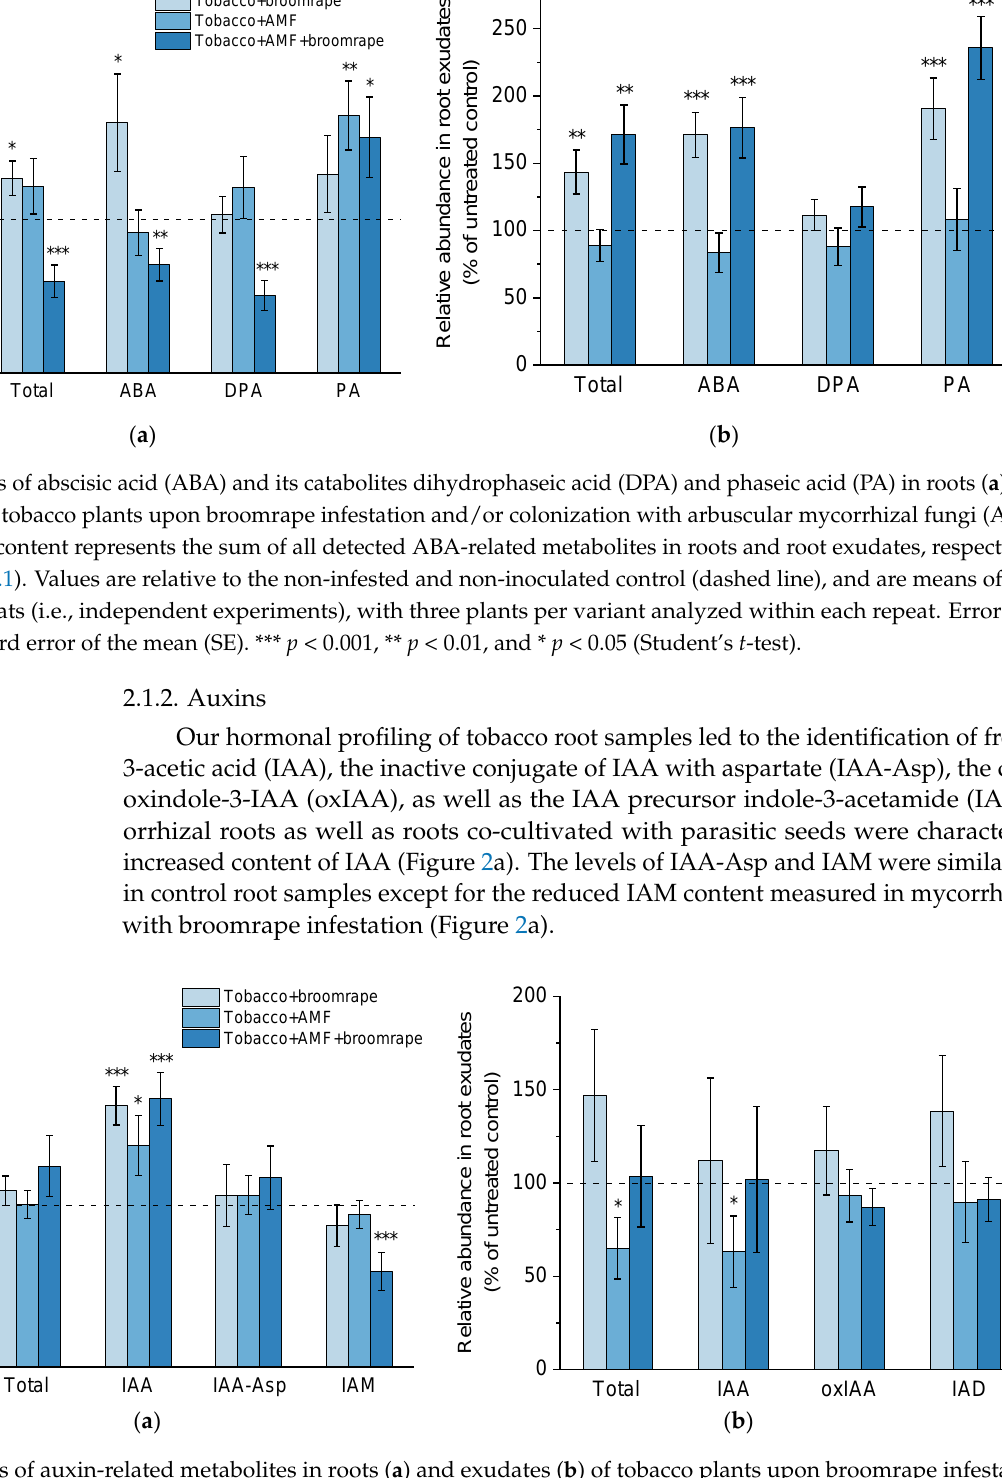
Figure 2. Levels of auxin-related metabolites in roots ( a ) and exudates ( b ) of tobacco plants upon broomrape infestation and/or colonization with arbuscular mycorrhizal fungi (AMF). The total auxin content represents the sum of all detected IAA-related metabolites in roots and root exudates, respectively (see Section 2.1.2). Values are relative to the non-infested and non-inoculated control (dashed line), and are means of four biological repeats (i.e., independent experiments), with three plants per variant analyzed within each repeat. Error bars indicate standard error of the mean (SE). *** p < 0.001 and * p < 0.05 (Student’s t -test). Abbreviations: indole-3-acetic acid (IAA), IAA-aspartate (IAA-Asp), indole-3-acetamide (IAM), oxindole-3-IAA (oxIAA), indole-3-carboxaldehyde (IAD).